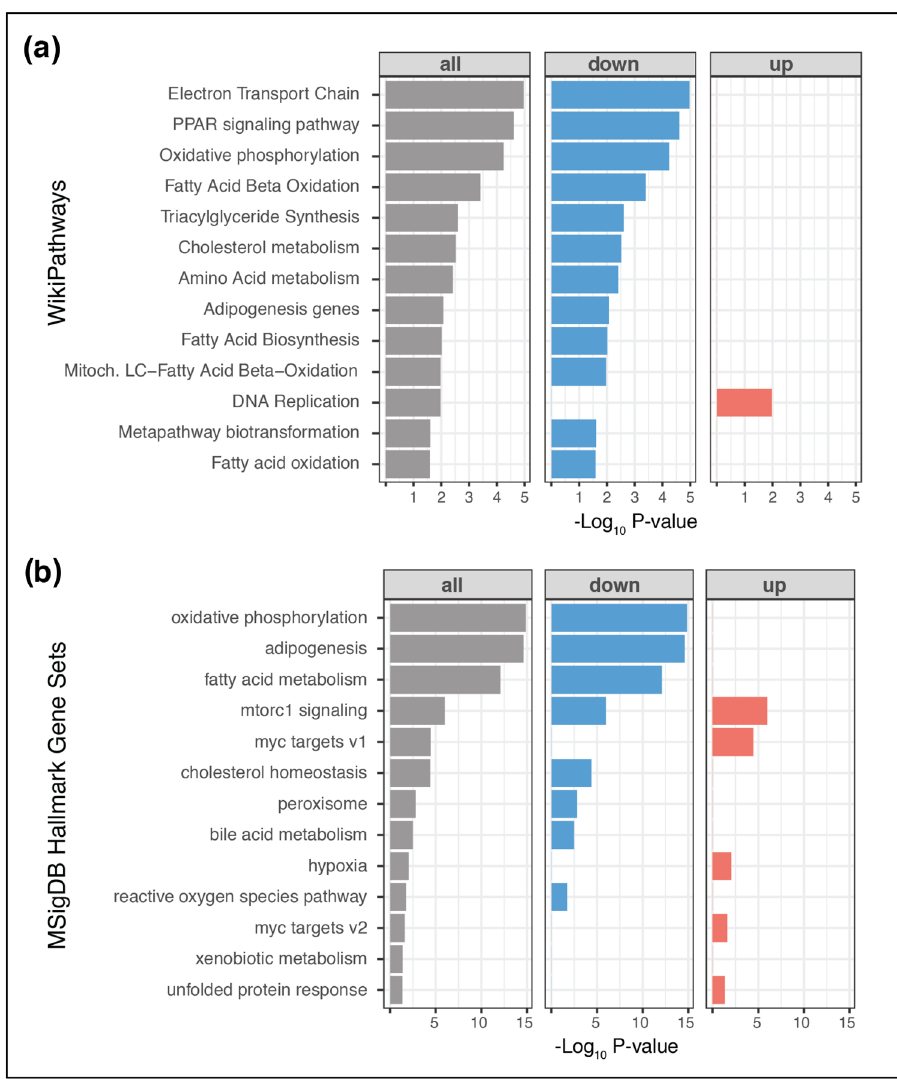
Figure 3. Identification of significantly-altered molecular pathways in SIRT1-depleted adipocytes. Prediction of significantly-affected molecular pathways by “WikiPathways” analysis ( a ) or MSigDB Hallmark gene-sets ( b ) in SIRT1-depleted adipocytes. Annotations from WikiPathways analysis or MSigDB Hallmark gene-sets were used for functional enrichment analysis among differentially expressed proteins (P < 0.05). Significantly enriched pathways (P < 0.05) were used for plotting. Axes show p-value of overlap and highlighted in red and blue are the up-regulated and down-regulated protein sets,